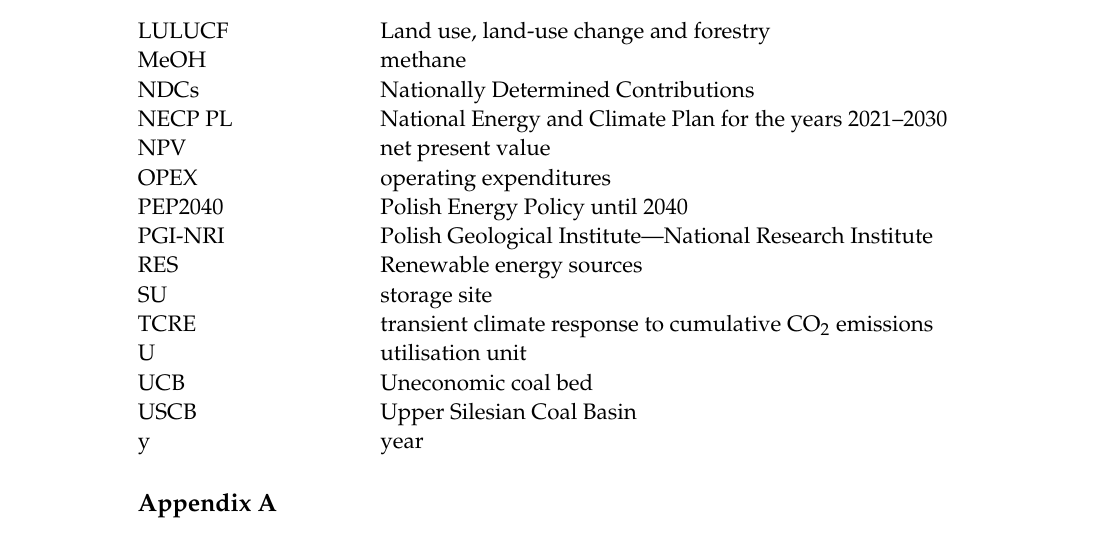
Table A1. Cash flows and detailed calculation of